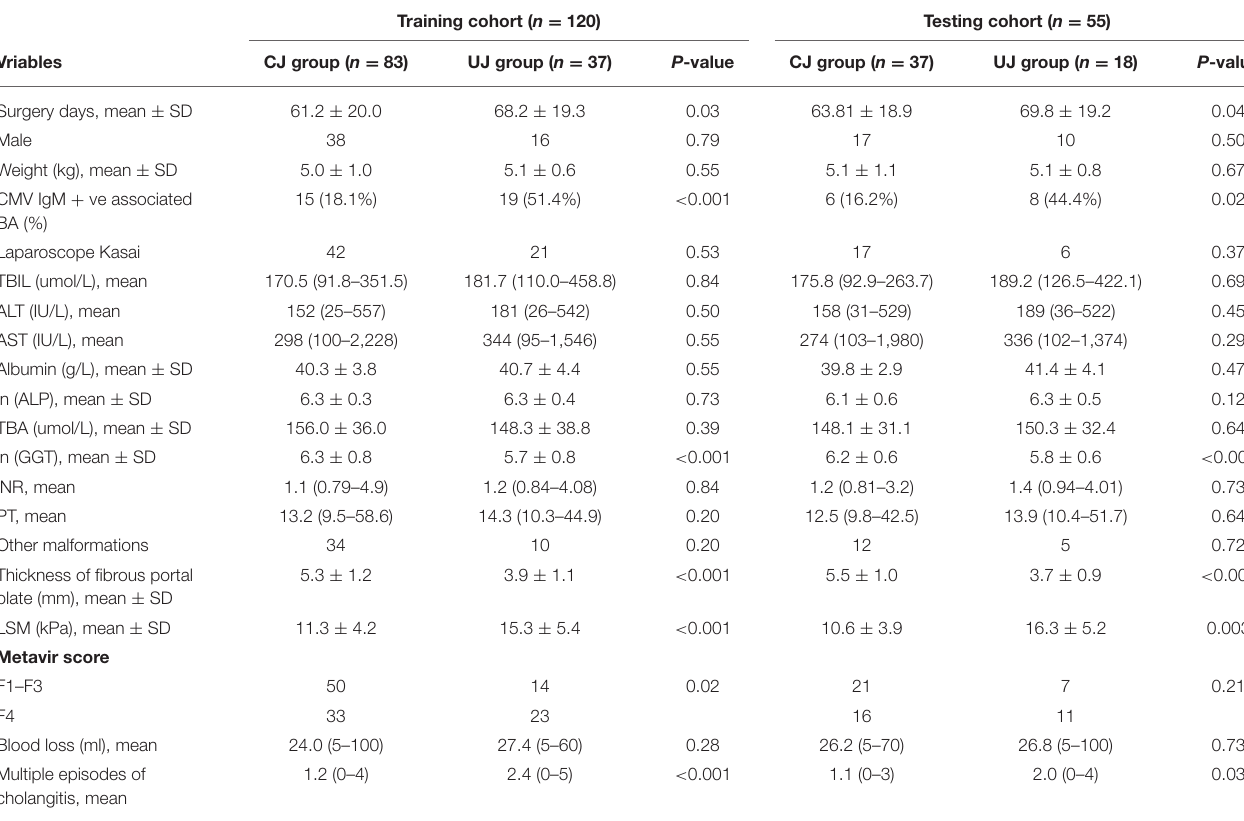
TABLE 2 | Characteristic of the patients and univariate analysis in training and testing cohort.